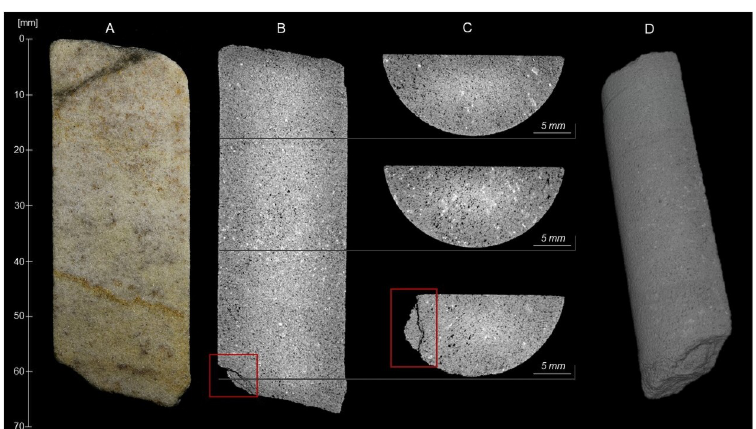
Fig 9. Optical (A) and Computed Tomography (B-C) images of section 2–3 of the Phillips’ Core from Stone 58 at Stonehenge. Distance along the sample is measured relative to the fracture plane between sections 1 and 2 of the Phillips’ Core (see Fig 5). Dark grey to black tones in the CT images indicate low density areas (e.g. pores, fractures), while light grey to white tones indicate high density areas (e.g. mineral constituents). A 3D reconstruction of sample (D) with full simulation is provided in the S1 Movie. These images are reproduced under a CC BY 4.0 license, with permission from British Geological Survey, original copyright (2019).